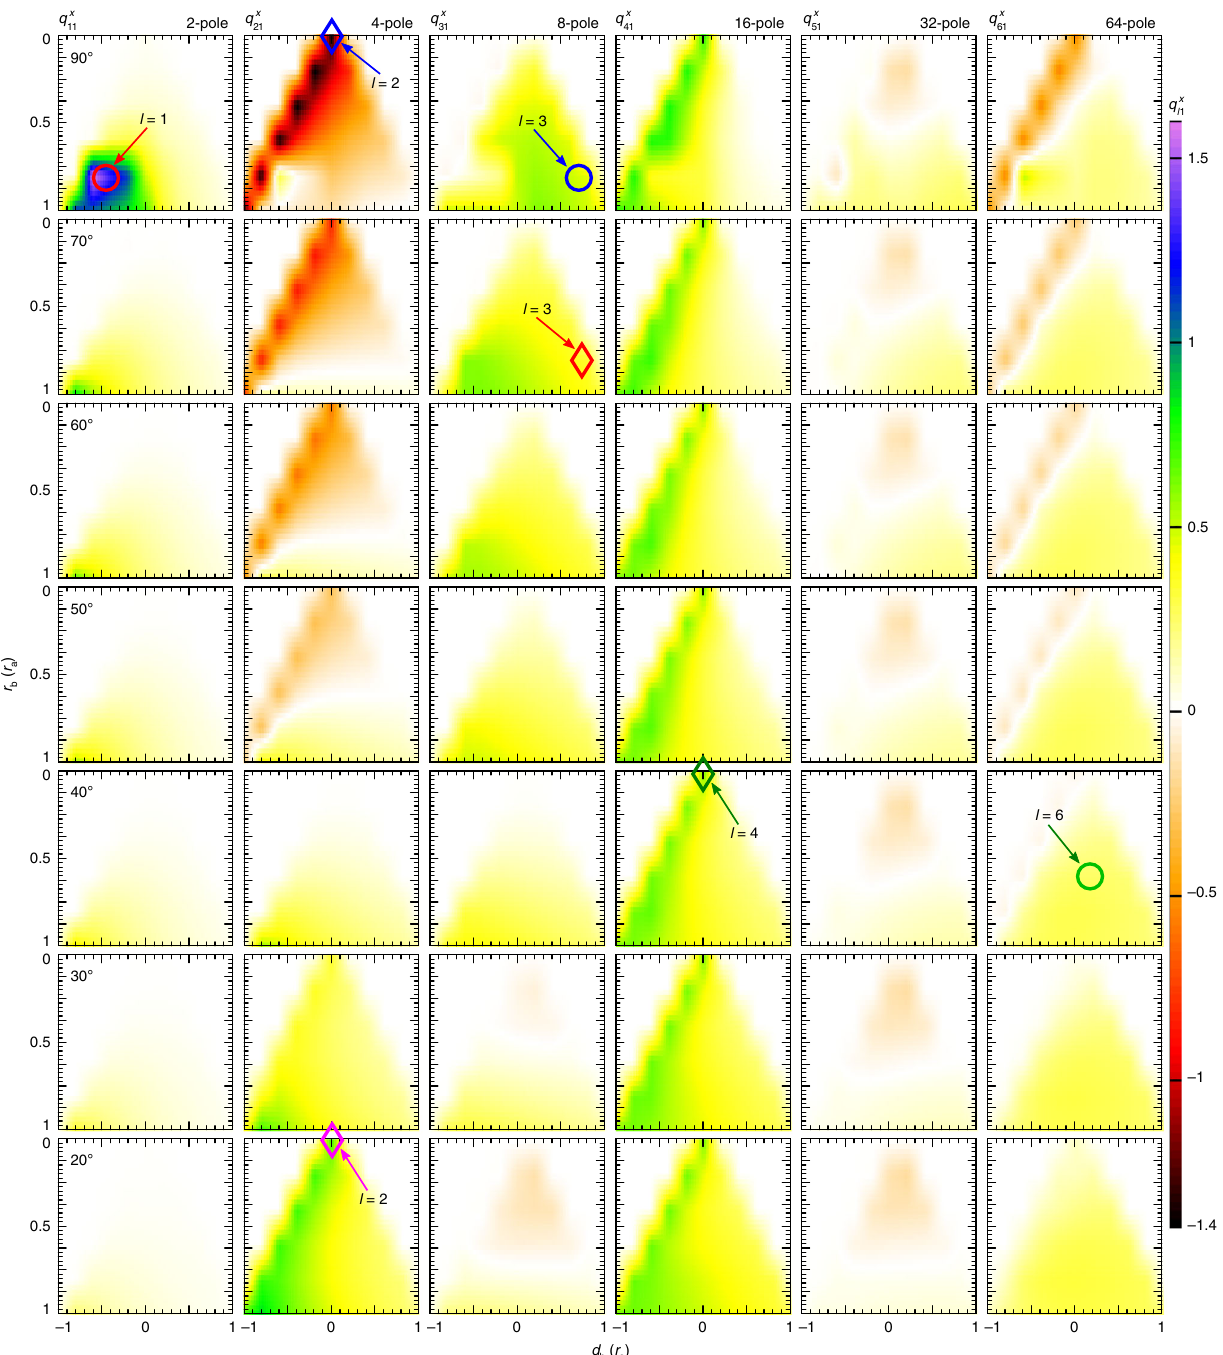
( l = 1 – 6) were calculated at the particles geometrical center for all Fig. 6 Spherical multipole moments of composite gourd-like colloids. Values of q x l 1 simulated composite gourd-like colloids with various conic anchoring angles at the lower lobe. Strong dipole emerges for particles near r b = 4/5, d b = − 2/5, quadrupole is most pronounced for a spherical particle with homeotropic or nearly tangential boundary condition. Octupole is larger for composites with large upper spheres and conic anchoring, whereas the strong hexadecapole emerges for spherical particles with conic anchoring on the surfaces. 32- and 64-pole are generally weak compared to the others because the neck defect region only slightly perturb n ( r ). Note that the multipole moments are calculated only in discrete points and interpolated for better visibility. Circles point to multipole moments of con fi gurations with parameters close to experimentally realized: red circle corresponds to a dipole in Fig. 4d, h , blue circle corresponds to the colloid with an octupolar con fi guration in Fig. 4a and green circle corresponds to a 64-pole in Fig. 3. Rhombs point to the diagram regions with dominant or “ pure ” multipole moments: blue and magenta rhombs show respectively quadrupoles with a Saturn ring and boojums; red and green rhombs point, respectively, to dominant octupole and